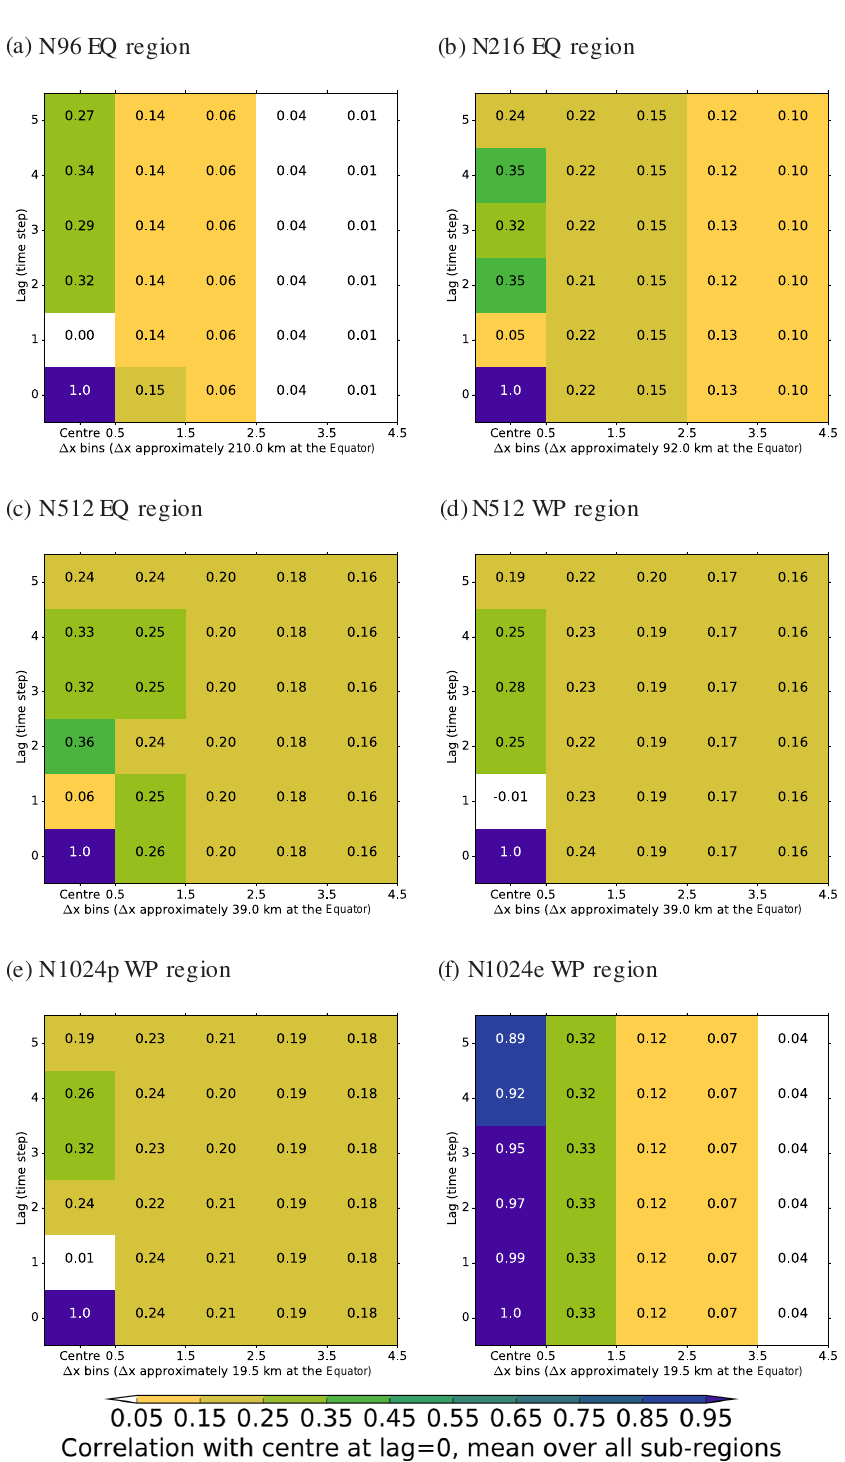
Figure 3. For each model and using time step precipitation on the native horizontal grid, filled boxes and numbers show the lagged cor- relations between the central grid box in each 7 × 7 sub-region and grid boxes within each range of distance on the horizontal axis (in units of the longitudinal grid spacing at the equator, (cid:49)x) away from the central point, averaged over all 7 × 7 regions. “Centre” denotes the auto-correlation at the central grid